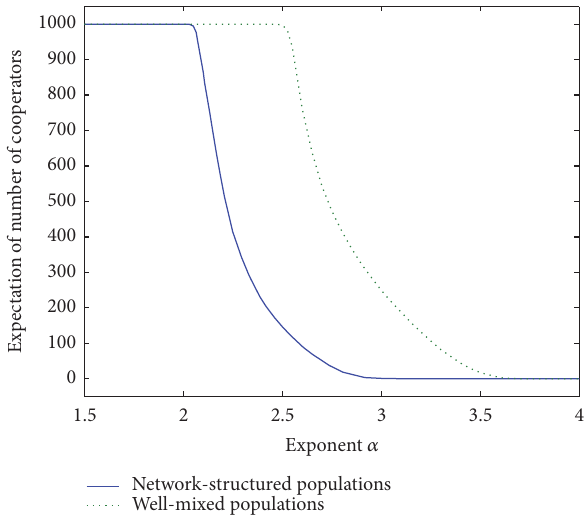
Figure 5: The number of the cooperators in the equilibrium according to the power law exponent 𝛼 . The dotted line represents, for a value of 𝛼 ranging from 1.5 to 4, how many cooperators out of 1,000 population remain in the end. The results are obtained from an ensemble average of 100,000 Monte Carlo realizations. The solid line illustrates the mean number of the cooperators when the population is structured on a scale-free network. See Section